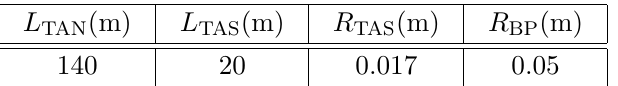
Table 2 . Dimensions of the LHC infrastructure: L TAN and L TAS are the distances to the TAN neutral particle absorber and the TAS quadrupole absorber, respectively, from IP, and R TAS and R BP are the radiuses of TAS and the LHC beam